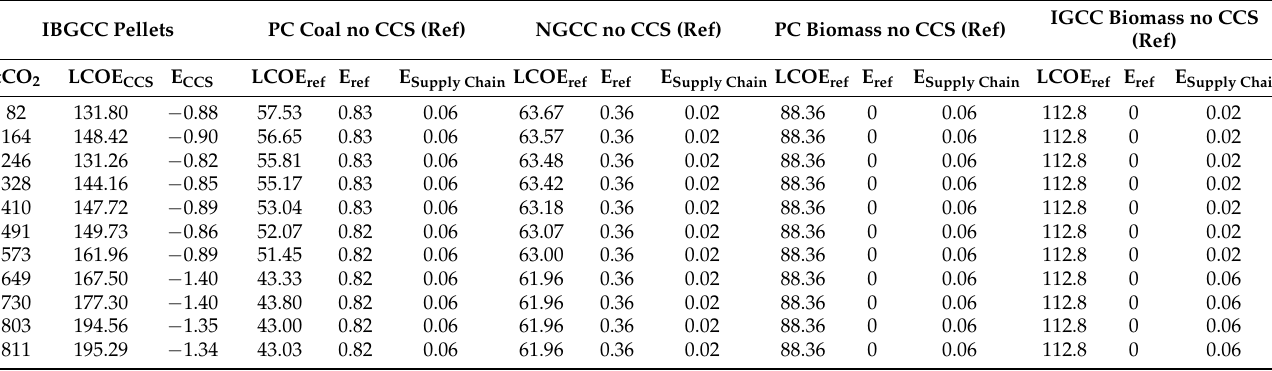
Table A6. Levelized Cost of Electricity (LCOE, in $/MWh) and Emissions Intensity (E, in tCO 2 /MWh) for the four CAC reference cases and IBGCC non-pelletized powerplants.